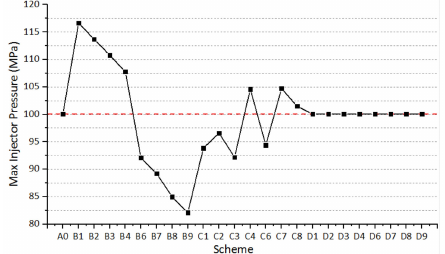
Figure 38. Max injection pressure for each optimized case.